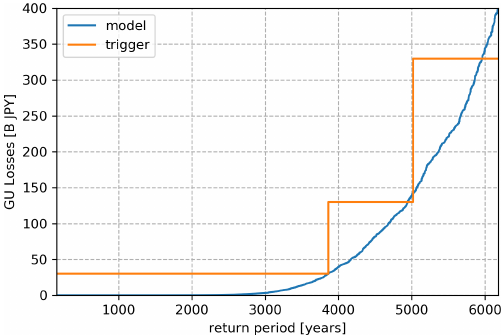
Table 4. Total number of dwellings and total reconstruction val- ues modelled in the volcano risk model for six Japanese volca- noes (by prefecture, and totals). Number of dwellings are from